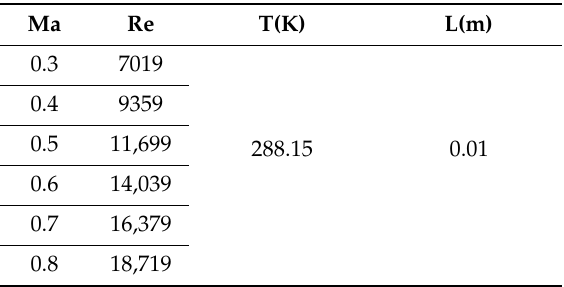
Table 2. The parameter of free